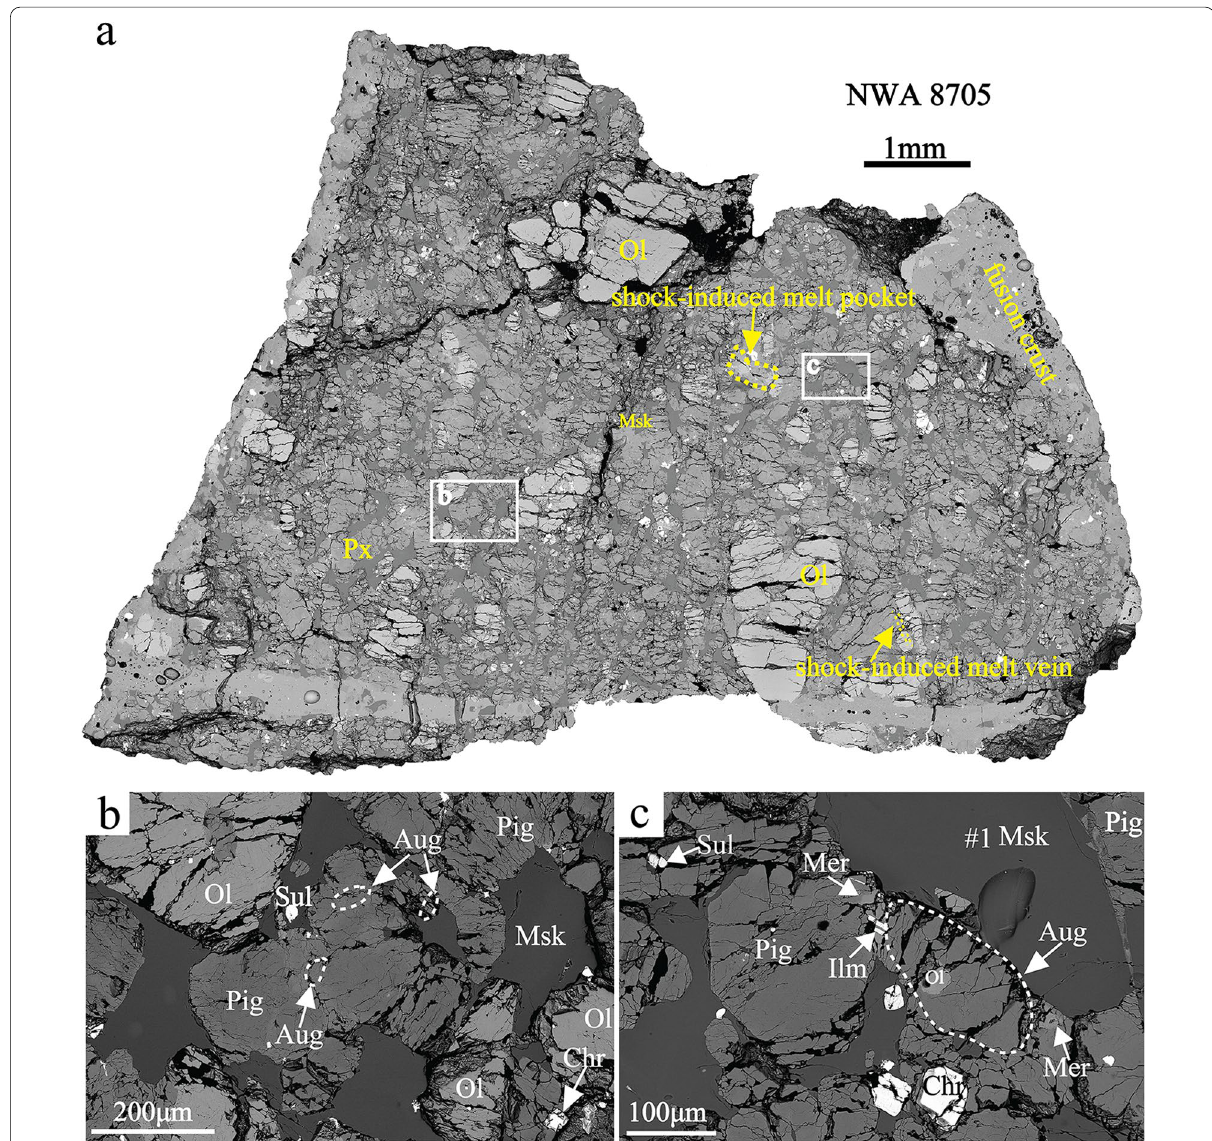
Fig. 1 BSE images of NWA 8705. a BSE mosaic map of NWA 8705. Shock-induced melt veins and pockets are indicated by yellow dotted lines and arrows. b , c are the enlarged BSE images of NWA 8705 marked as white boxes in a . Augite (Aug) occurs as the margin of pigeonite (Pig) or as individual grains (outlined by dotted lines). Note abundant fractures of olivine and pyroxene, in comparison with the smooth surface of maskelynite. #1 is the position of a Raman analysis of maskelynite (Msk). Other abbreviations: Rwt ringwoodite, Chr chromite, Mer merrillite, Ilm ilmenite,